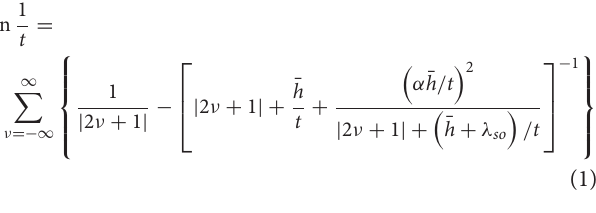
FIGURE 3 | C ( T )of Ti 15 Zr 15 Nb 35 Ta 35 for H shows C / T vs T 2 under magnetic field. And the lower right inset is C es /γ T c plotted on a logarithmic scale as a function of T c / T .